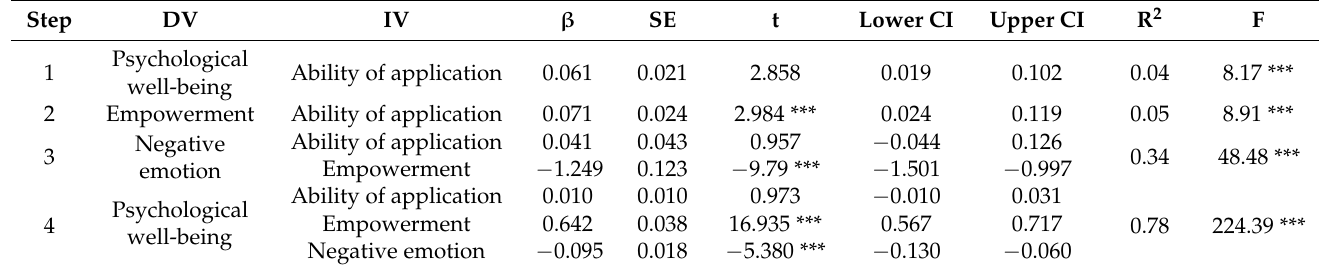
Table 2. Mediation effect of empowerment and negative emotion.